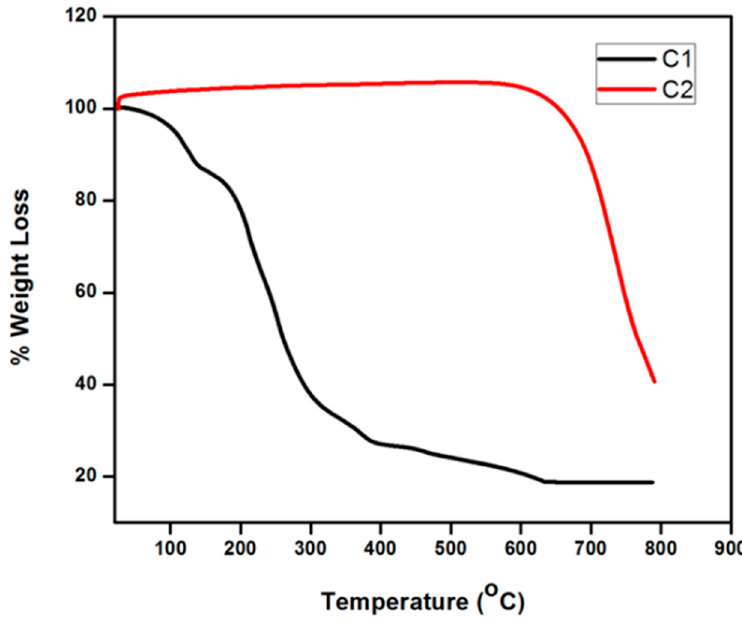
Figure 1. Thermo gravimetric Analysis (TGA) curves of Polyethylene Glycol (PEG)-capped particles with ethanol before washing (C1) and after (C2) washing.